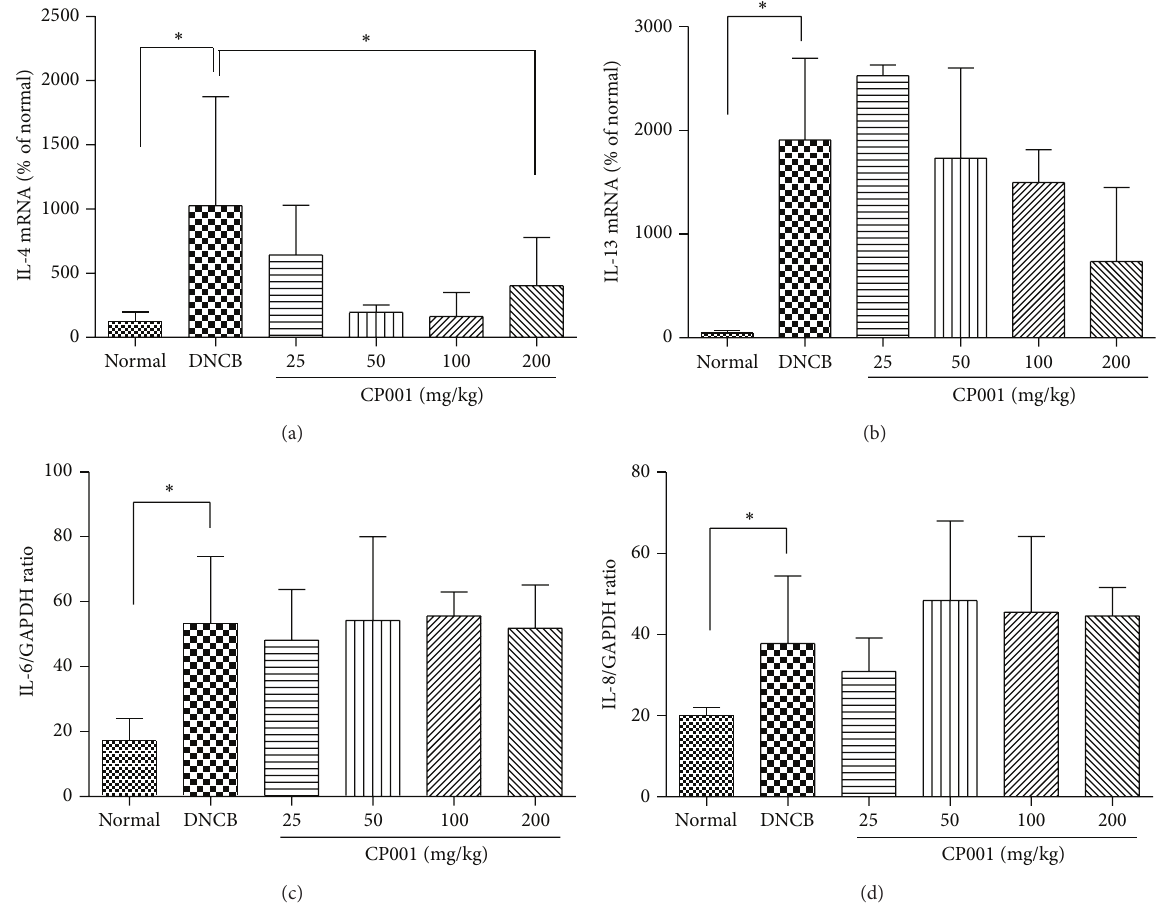
Figure 4: Effect of CP001 on the cytokine mRNA expression in mouse skin tissue. The IL-4, IL-13, IL6, and IL-8 mRNA expression were measured by real-time PCR (a), (b) and RT-PCR (c), (d) in mouse skin tissue. The columns and the error bars represent mean ± SD ( 𝑛 = 5 mice/group). ∗ 𝑃 < 0.05 .